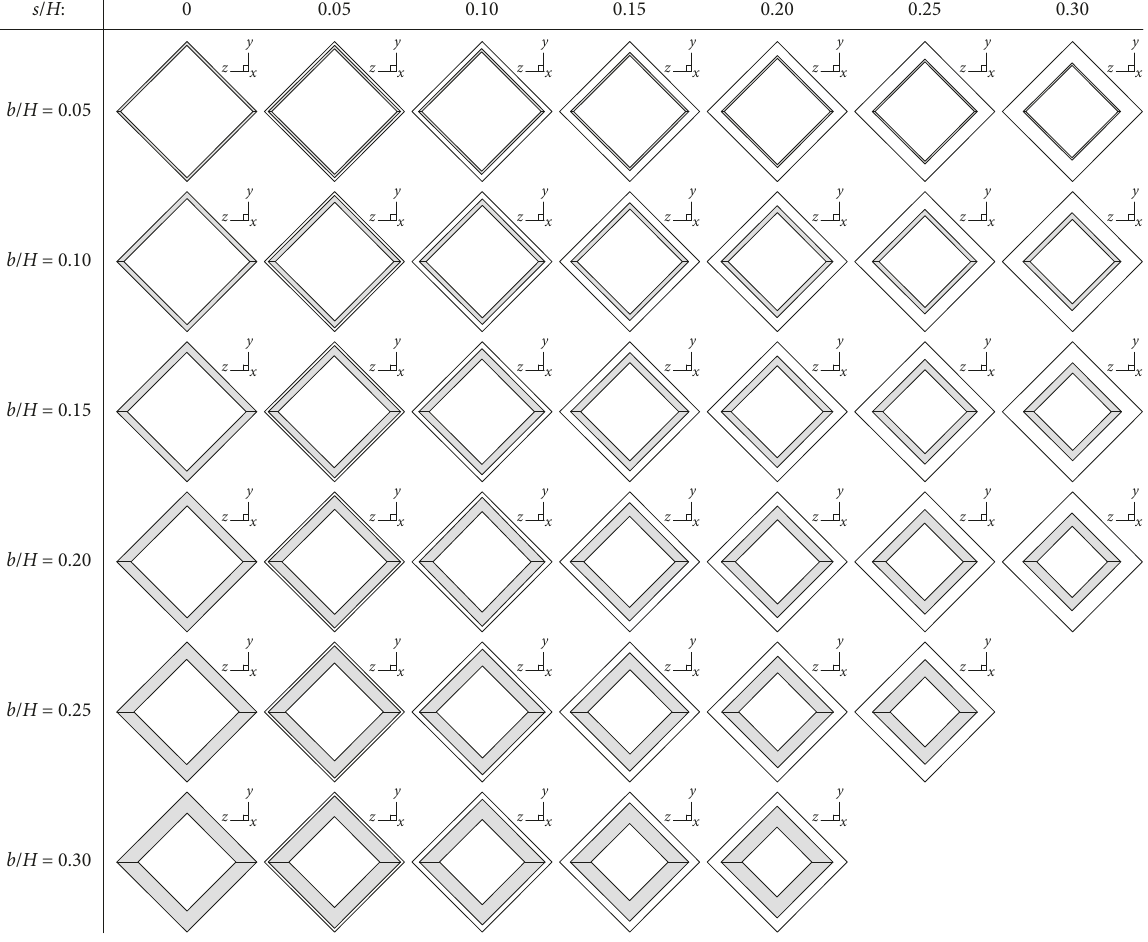
Figure 2: Square duct installed with the 45 ° ISR in the y - z plane at various